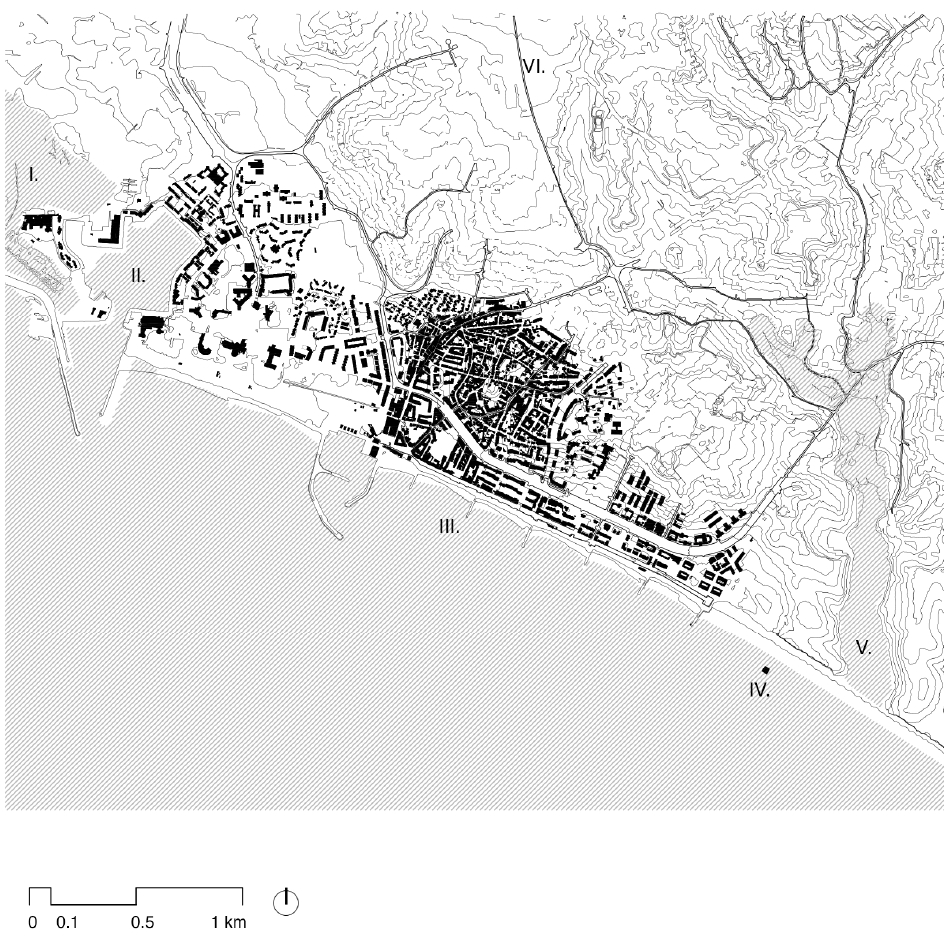
Figure 3. I. Quarteira Stream; II. Vilamoura; III. Quarteira; IV. Almargem Stream; V. Fortress ruins; VI. Streets. Cartographic bases provided by Câmara Municipal de Loulé. Authors’ edition, 2023.